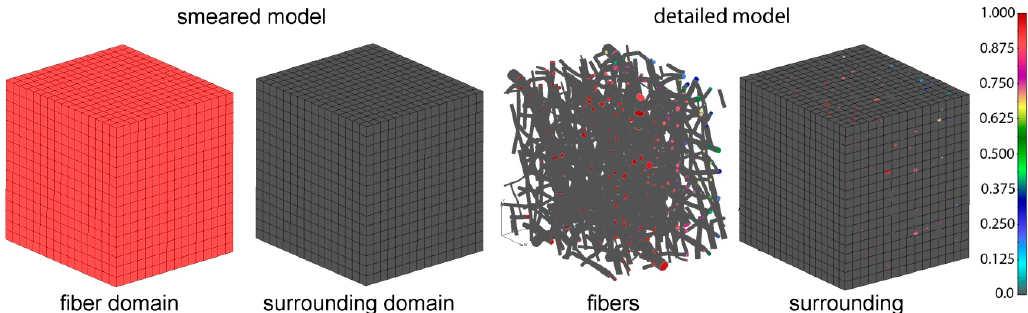
Figure 8. PLGA domain modeled using a smeared composite finite element or detailed model with the mesh of fibers.